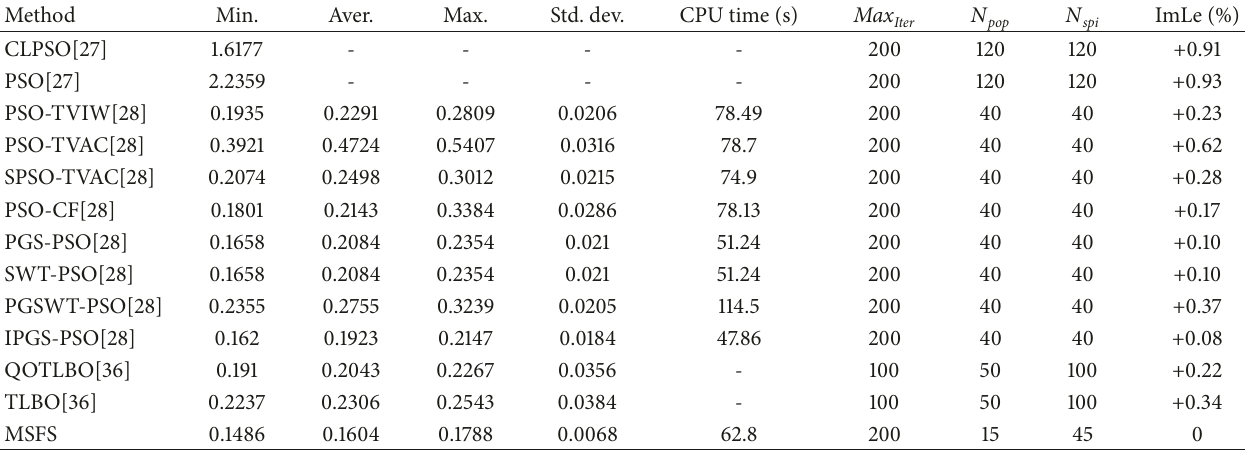
Table 9: Comparison of results obtained from IEEE 118-bus system with TVD optimization.